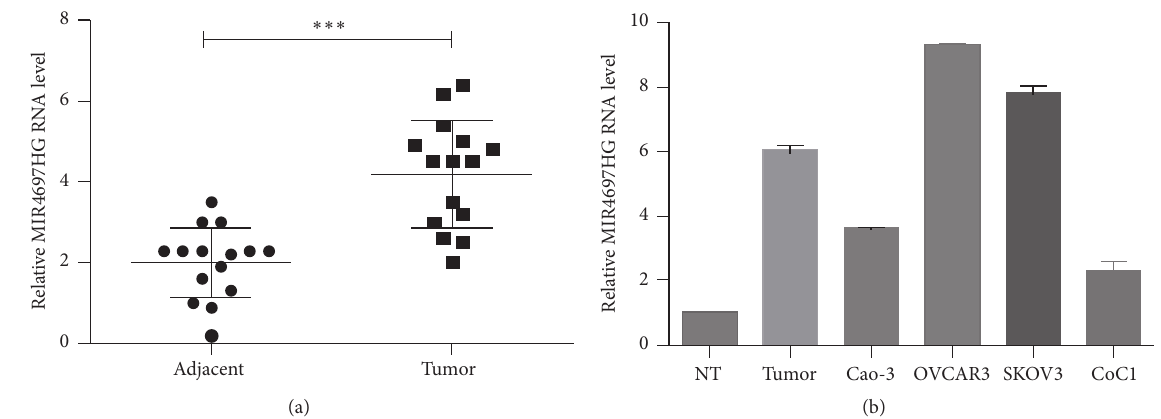
Figure1:MIR4697HGisupregulatedinovariancancertissuesanddifferentiallyexpressedinovariancancercelllines.(a)qRT-PCRanalysisof theMIR4697HGlevelin15casesofovariancancertissuesandtheiradjacentnoncanceroustissues. ∗∗∗ 𝑝 < 0.001 .(b)TherelativeMIR4697HG level in normal ovary tissues (NT), ovarian cancer tissues, and four ovarian cancer cell lines (Caov-3, OVCAR3, SKOV3, and CoC1) were